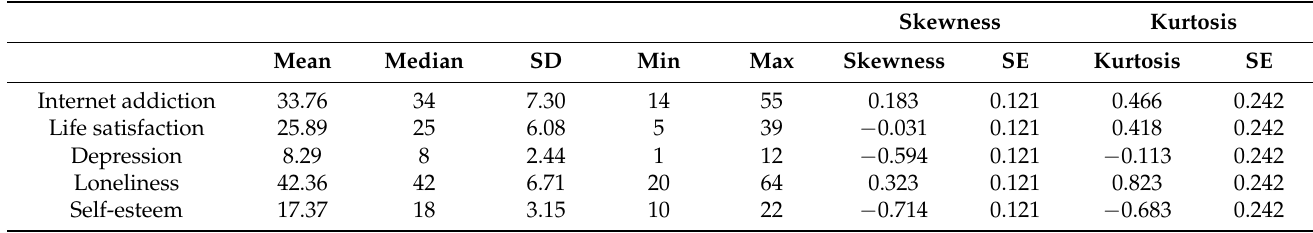
Table 2. Participants’ score distribution of IA, depression, UCLA LS, LS, and